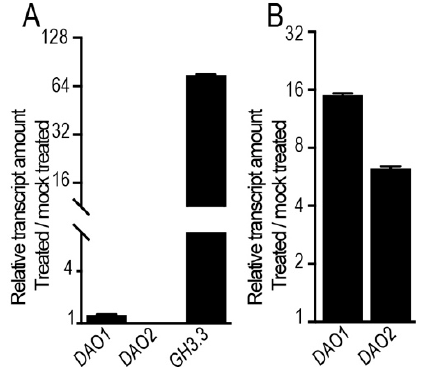
Figure 2. JA controls the expression of DAO1 and DAO2 independently of TIR1 / AFB-dependent auxin signaling. ( A ) Relative transcript amount of DAO1 , DAO2 , and GH3.3 quantified by qRT-PCR. mRNAs were extracted from six-day-old wild-type seedlings treated for 1 h with 10 µ M indole-3-acetic acid (IAA) or mock solutions. The gene expression values are relative to the mock-treated control, for which the value was set to 1. ( B ) Relative transcript amount of DAO1 and DAO2 quantified by qRT-PCR. mRNAs were extracted from six-day-old wild-type seedlings pre-treated for 90 min with 10 µ M auxinole, then they were co-treated with 50 µ M JA and 10 µ M auxinole for 1 h. The gene expression values are relative to the mock-treated control, for which the value was set to 1. The scale in the Y axis is indicated as a log2 unit. Error bars indicate ± SEM obtained from three technical replicates. Wild-type seedlings were grown for five days under long-day conditions (16 h light / 8 h dark), then they were acclimated overnight in liquid media before any treatment. All the experiments were repeated at least twice and the biological replicates gave the same